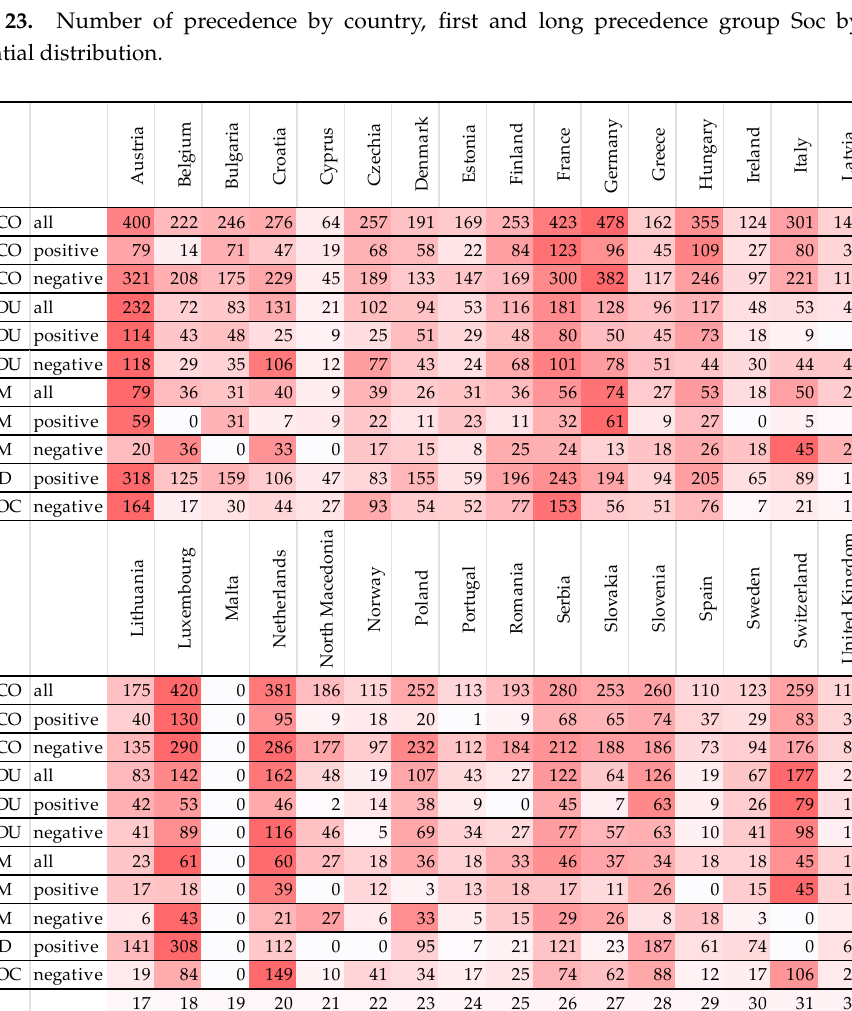
Figure 24. Summary first precedencies.